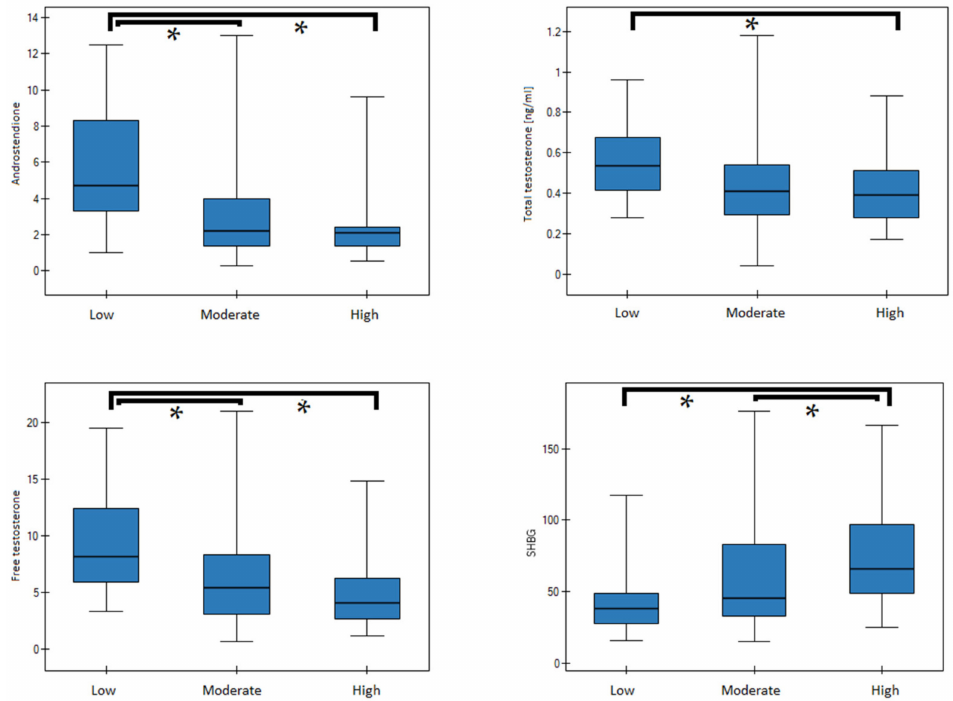
Figure 2. Median (25–75%) of sex hormone concentrations in groups with low, moderate or high PA (leisure). Significant differences are marked by an asterisk